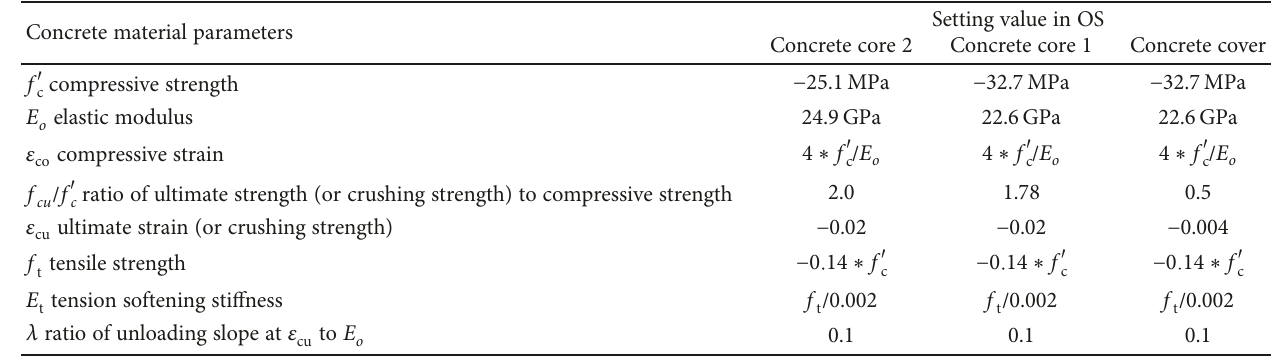
Table 2: Detailed setting of the parameters of concrete materials in OS.